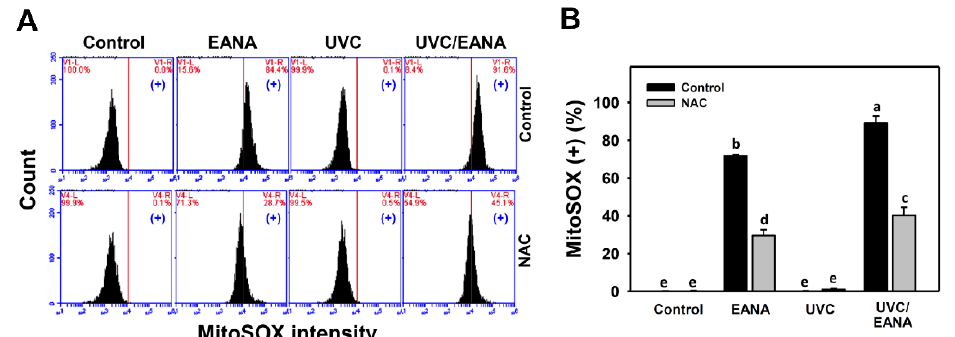
Figure 5. MitoSOX analyses of EANA and/or UV treatments for human oral cancer Ca9-22 cells. With or without NAC (10 mM) pretreatment for 1 h, cells were post-treated with control (DMSO only), EANA (5 µg/mL), UVC (12 J/m 2 ), and combined treatment (UVC/EANA) for 24 h. ( A ) Typical flow cytometry patterns for MitoSOX content. MitoSOX intensity-positive regions were marked as (+). ( B ) Statistical analysis for Figure 5A. Treatments showing no overlapping labels (a–e) differ significantly between multiple comparisons ( p < 0.001–0.0001). Data, mean ± SD ( n = 3).